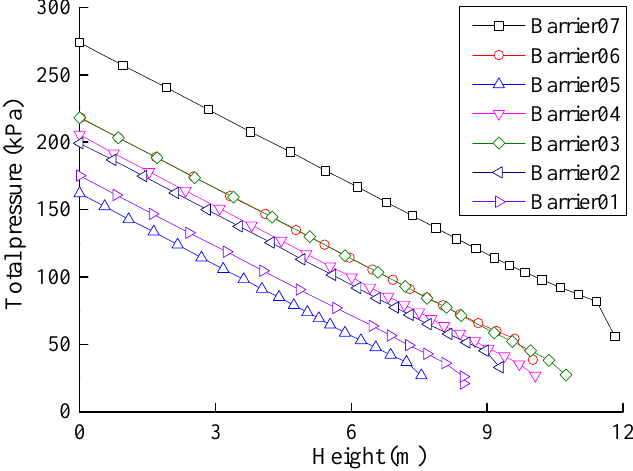
Figure 11. Variation of the safety factor of the barrier with deposition thickness at the front of the barrier.